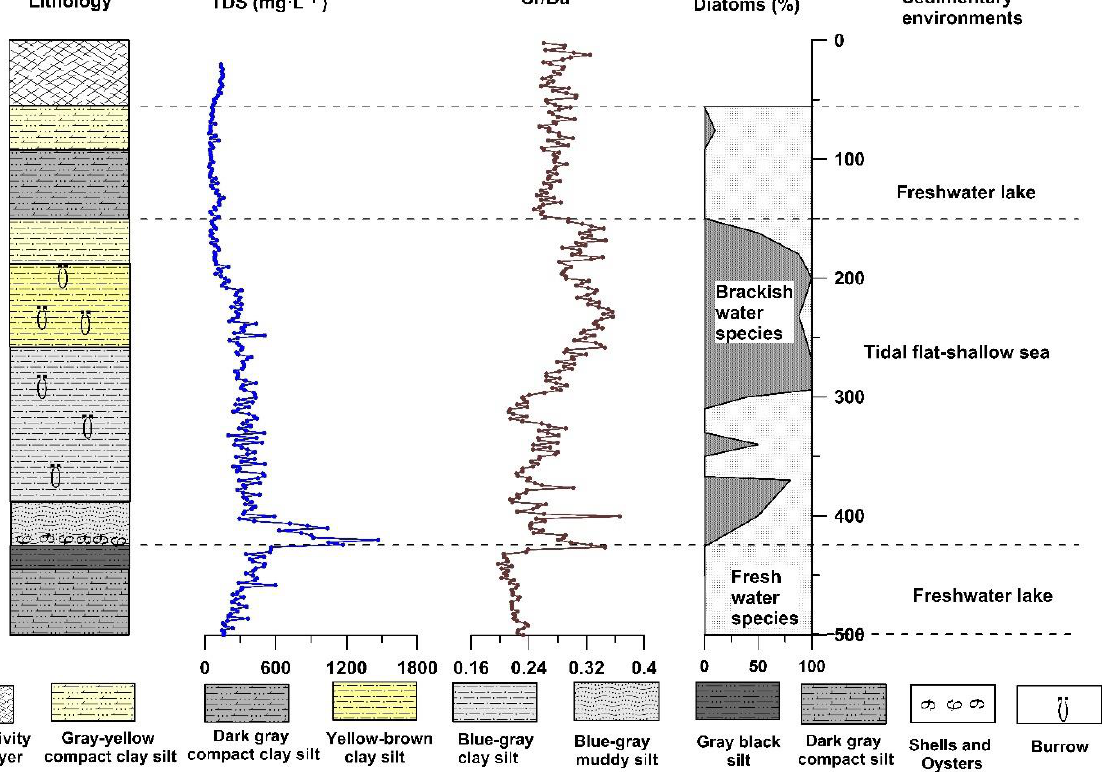
Figure 8. Comparison of lithology, TDS, Sr/Ba, and diatoms of GX section and sedimentary.